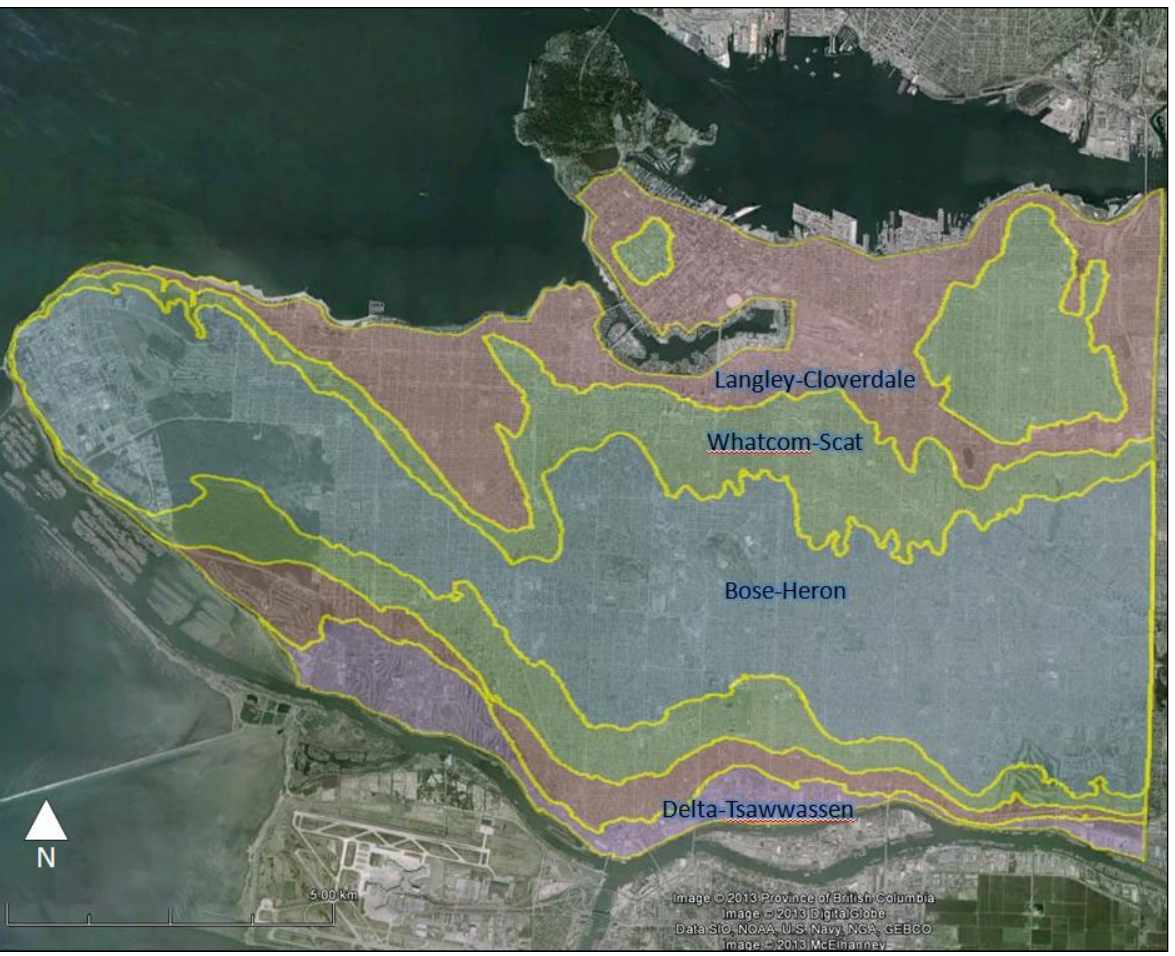
Figure 2. Map of Vancouver, British Columbia, Indicating the Four Soil Management